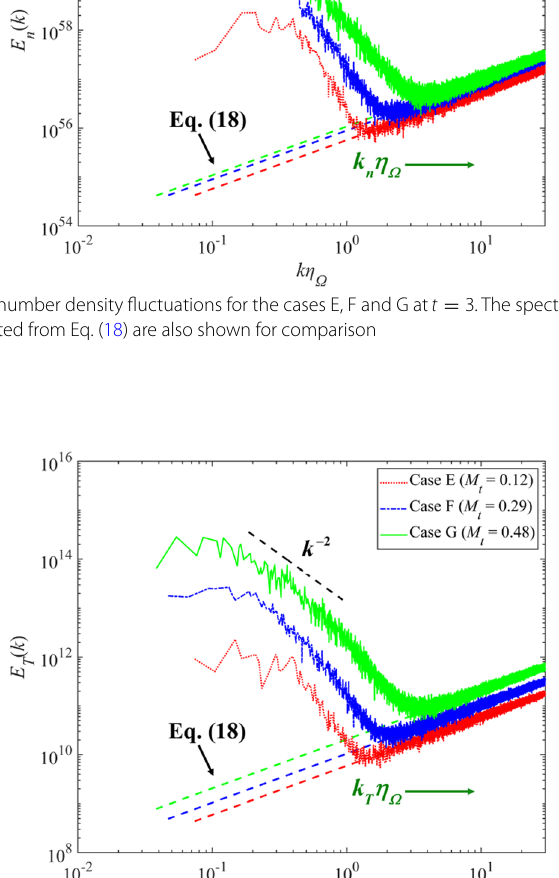
Fig. 14 Spectra of temperature fluctuations for the cases E, F and G at t fluctuations calculated from Eq. (18) are also shown for